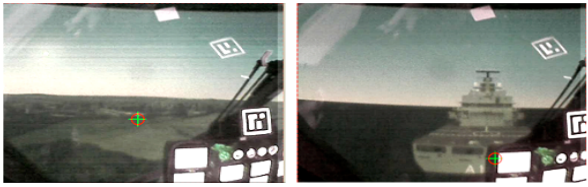
Figure 2. Screenshots of the Landing Maneuvers (Left: Pinnacle, Right: